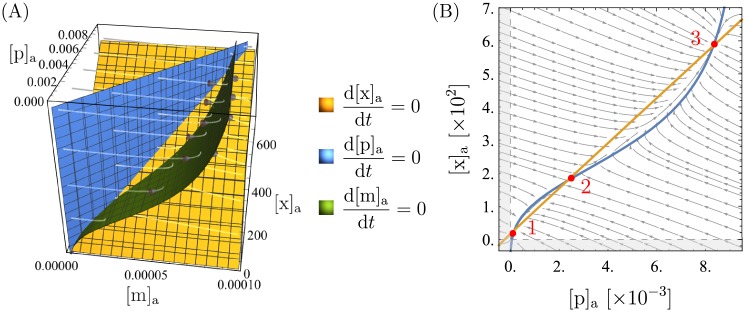
Phase portraits showing bistability.3D and 2D phase portraits for one set of parameters that leads to bistability. The parameter values are listed in Table 1. Note that all the concentrations ([m]a, [p]a, [x]a) are measured in units of Ka = 5 ⋅ 104 nM. The surfaces in (A) and the curves in (B) are the nullclines of the state variables, and their intersection points, marked in red in (B), are the steady-state solutions of the system. The region shaded in gray in (B) leads to negative concentrations and is unphysical. A vector plot of (B) that also shows the magnitude of flow at each point can be found in S1 Text.